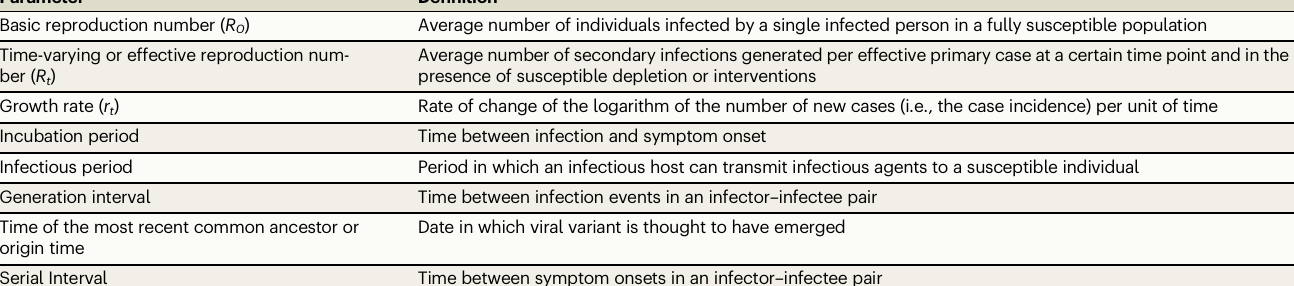
Table 1 | Key parameters and de fi nitions for SARS-CoV-2